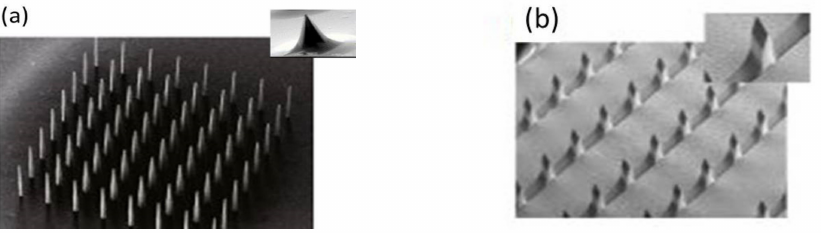
Figure 3. Scanning electron microscope (SEM) images of ( a ) out-of-plane MNs Source [115] (Adapted from Ref. [115]). ( b ) combined in-plane and out-of-plane MNs [116]. (Adapted with permission from Ref. [116]. Copyright 2008